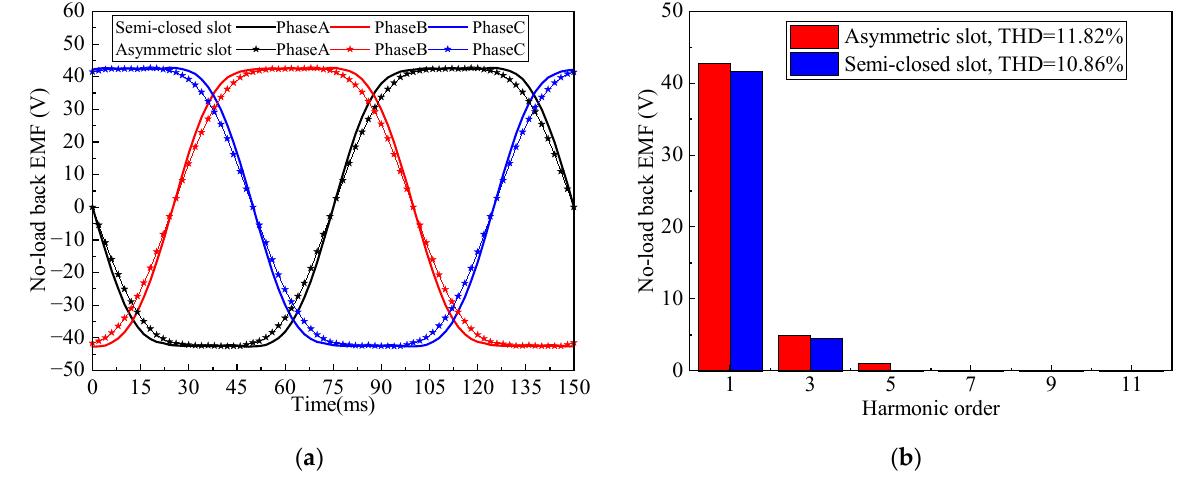
Figure 10. Comparison of no-load back EMF between semi-closed slot model and asymmetric slot model: ( a ) waveform; ( b ) harmonic analysis.